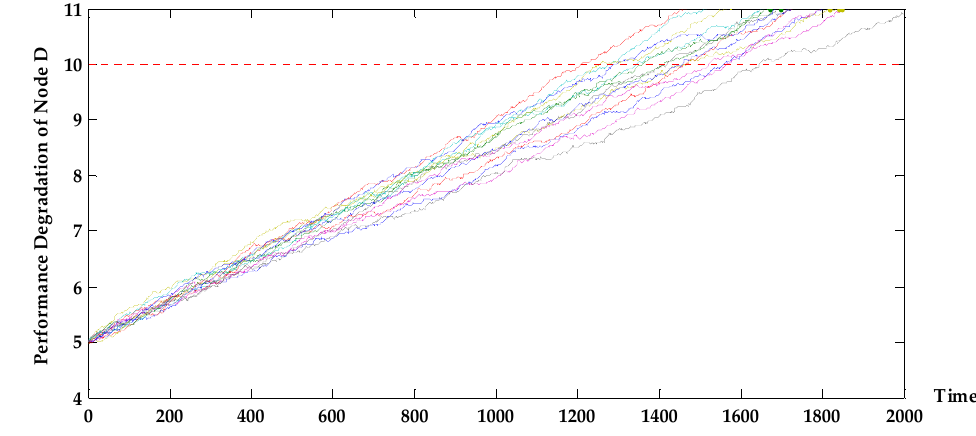
Figure 9. Simulation curve of performance degradation of device D . The dotted lines parallel to the horizontal axis of Figures 8 and 9 represent the device performance threshold.